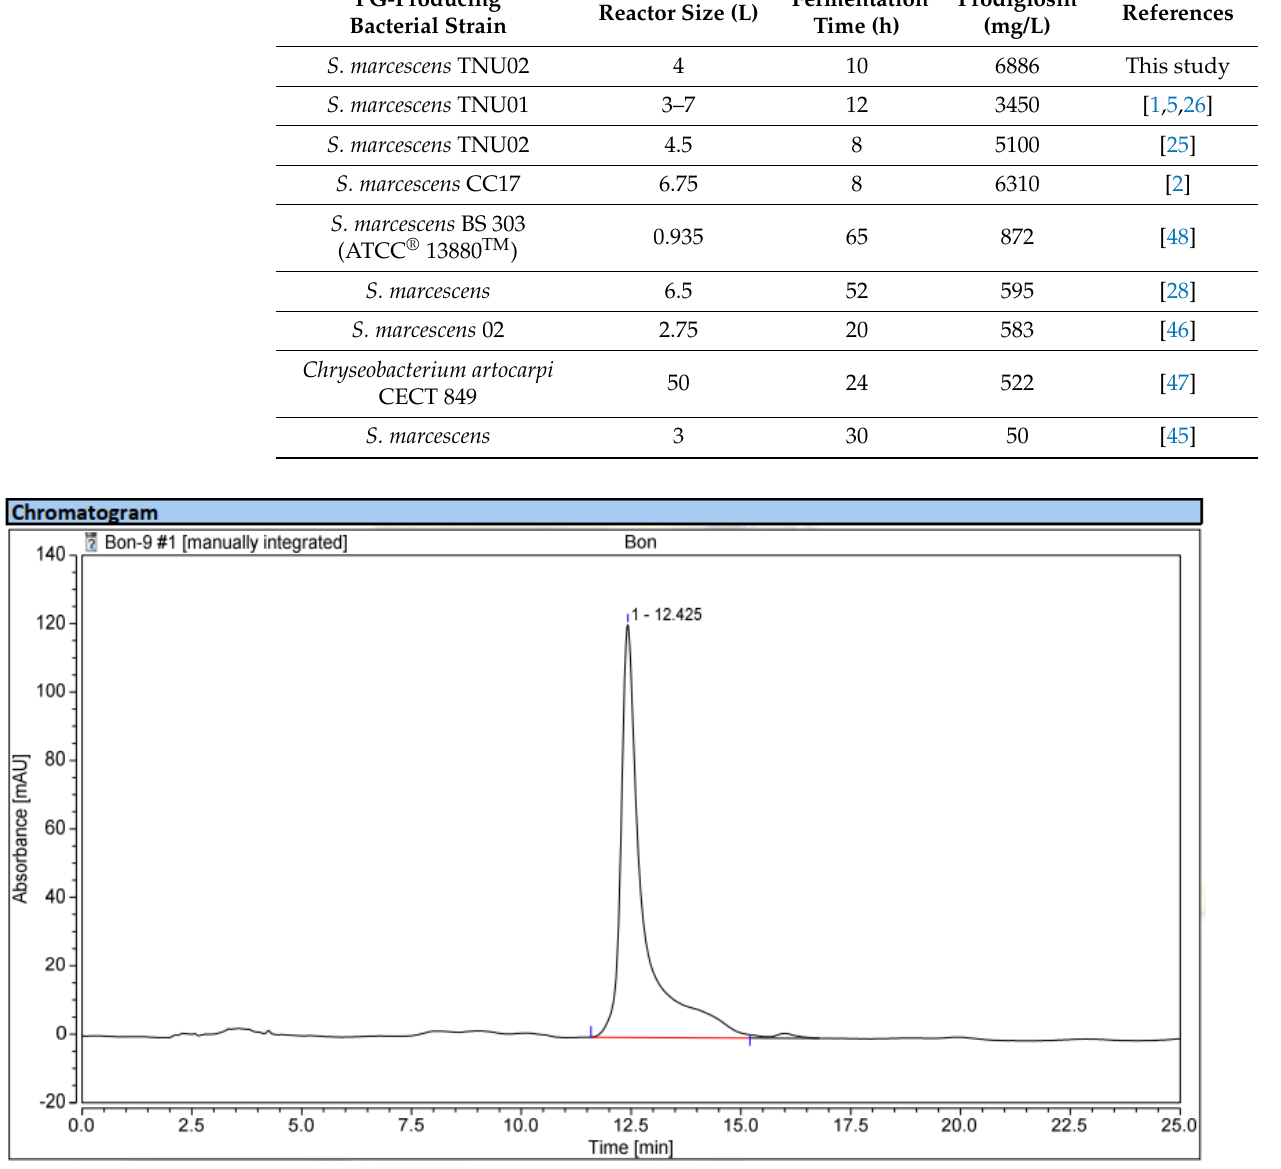
Figure 6. The high-performance liquid chromatography spectrum of prodigiosin produced in this work. The sample was dissolved in methanol at 1 mg/mL concentration and then injected (3 μ L) into the HPLC system. The analysis conditions were set at a flow rate of 0.8 mL/min for the column and keeping the column at 30 °C for 20 min. PG was detected at the wavelength of 535 nm.